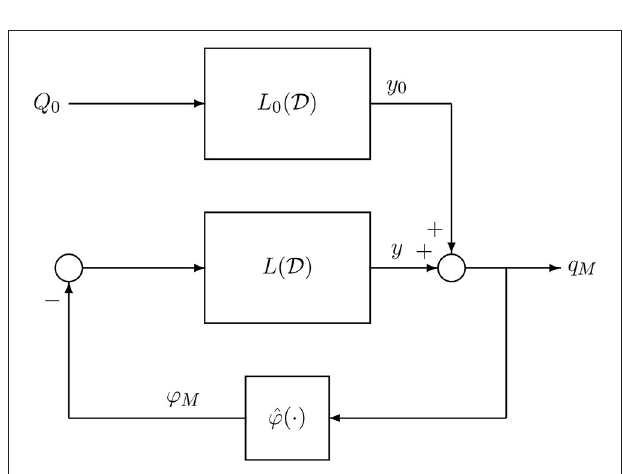
FIGURE 5 | Equivalent input-output representation of system